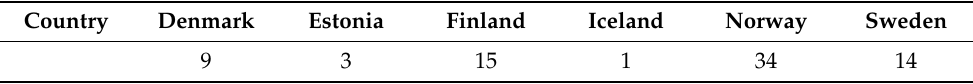
Table 2. Number of authors in the proceedings from each country.